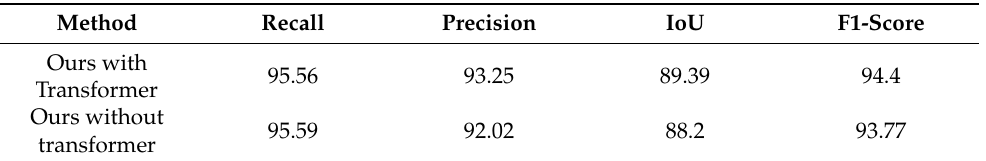
Table 4. Quantitative comparison results (%) between our method with and without the transformer module tested on the WHU